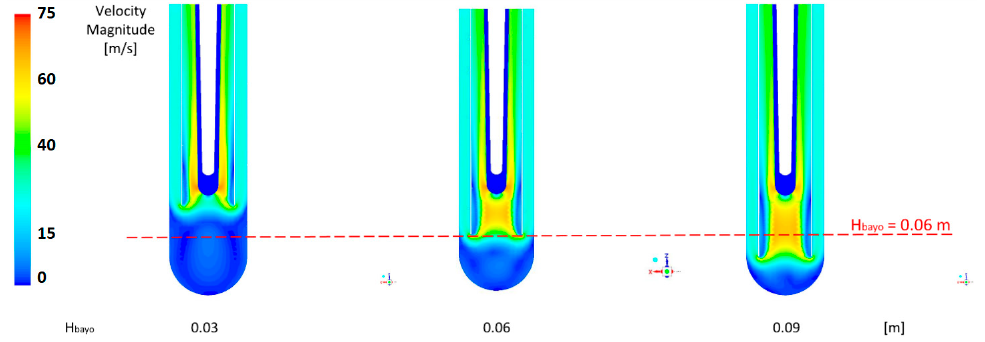
Figure 6. Comparison of velocity fields for H bayo equal to 0.03, 0.06 and 0.09 m.